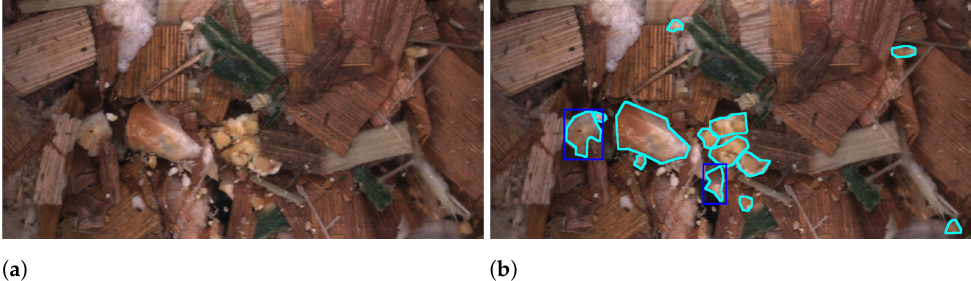
Figure 5. An example of how to annotate instances that are covered by other particles. Original image for reference in ( a ) and example annotation in ( b